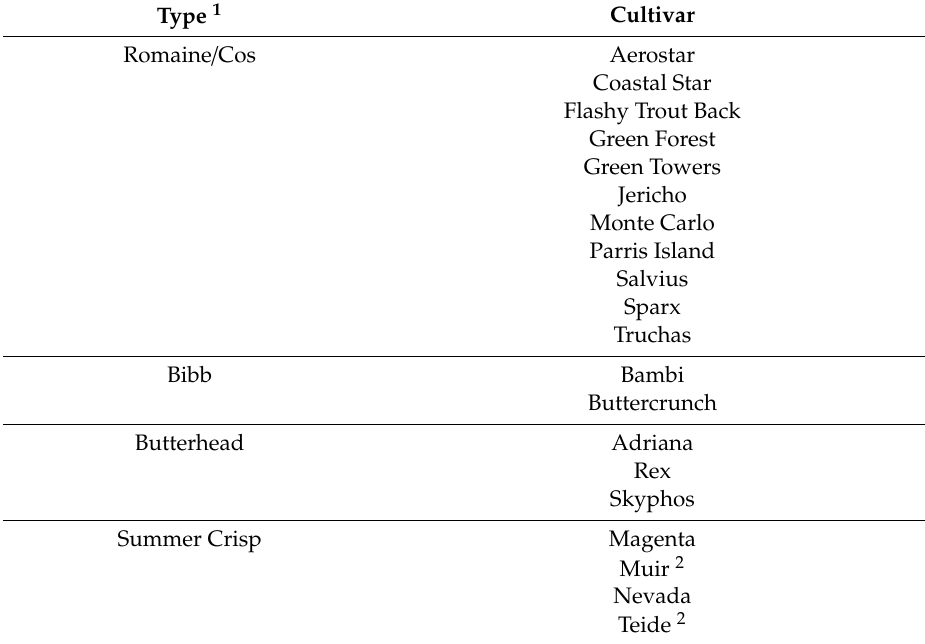
Table 1. The cultivars selected for heat tolerance trial based on their being marketed as heat tolerant and / or